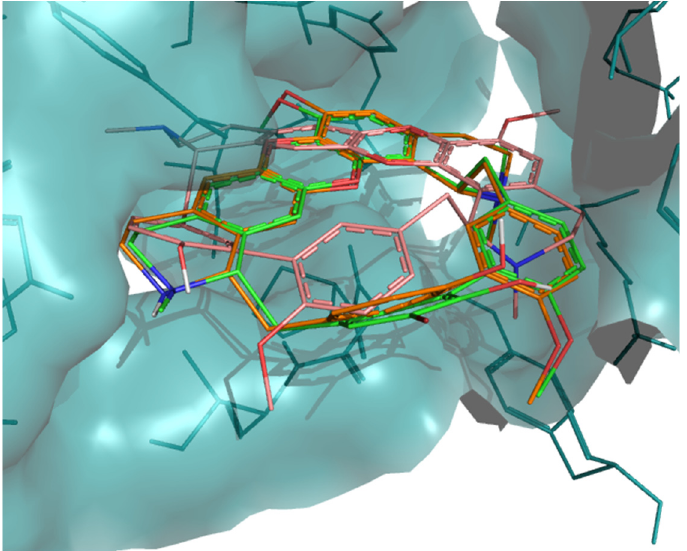
Figure 5. Superposition of best docking position of tiliacorine (pink), nortiliacorinine (orange) and 13 ′ -bromotiliacorine (green) against DprE1.